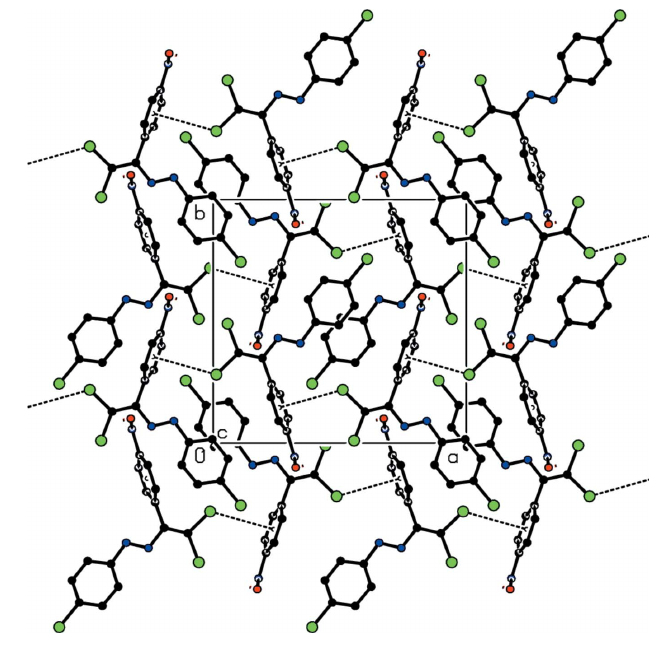
Figure 4 Aview of the packing in (I) along the a axis showing C—H (cid:3)(cid:3)(cid:3) Cl contacts.